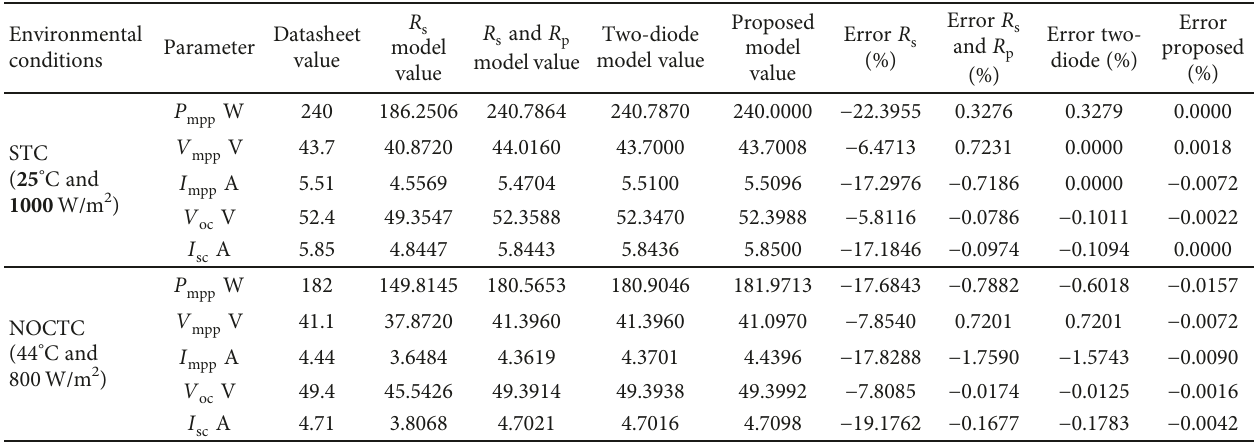
Table 6: Comparison of R HIT-N240SE10 PV module [33].